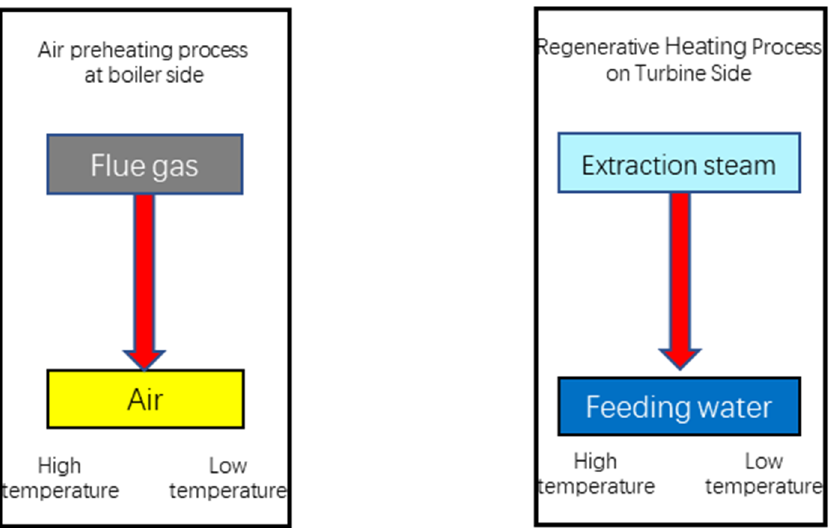
Figure 4. Heat exchange process between traditional boiler side and steam turbine side.